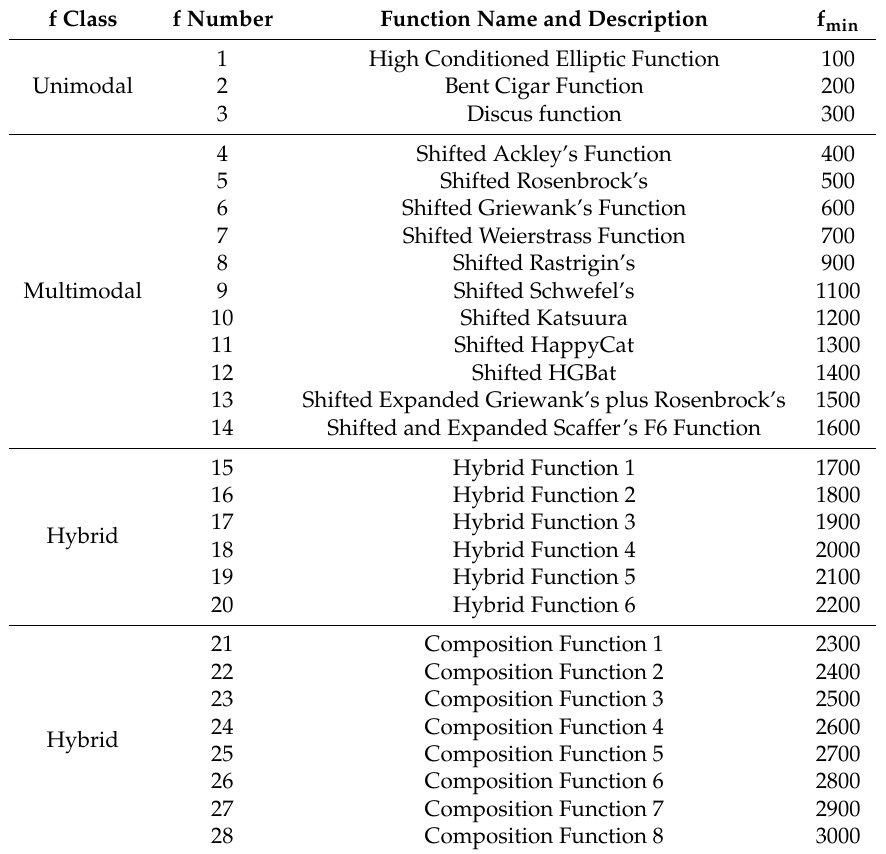
Table 2. R-CEC14 (R stands for rotation flag) benchmark suite. Each problem can be evaluated with and without the action of the rotation. Further details on these problems and the rotation procedure are available at